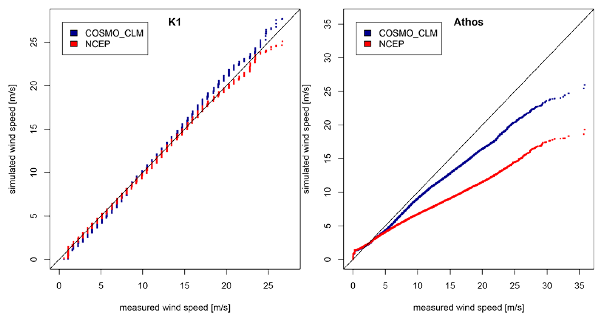
Figure 10. Validation of near-surface wind speeds: quantile– quantile plot for Atlantic o ff shore conditions (left: 2007–2012, plat- form K1 height corrected) and near-shore Mediterranean conditions (right: 2000–2012, buoy